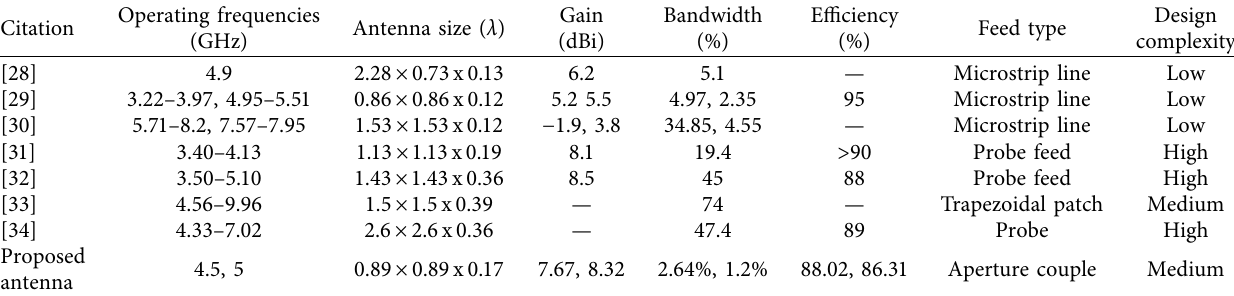
Table 3: Comparison of the proposed antenna with